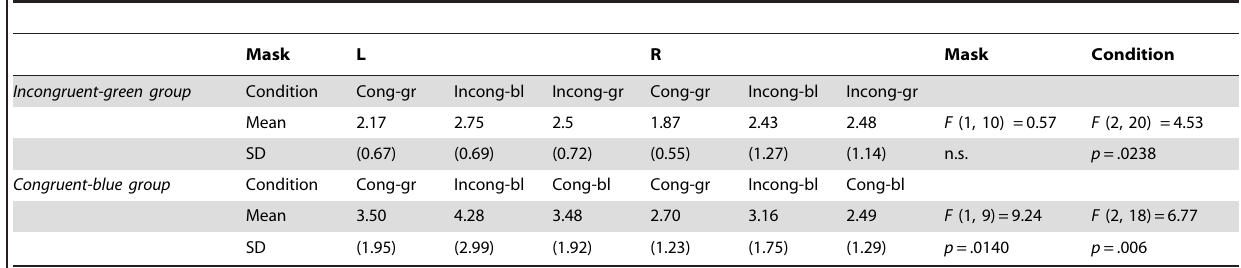
Table 4. Mean endpoint errors in each condition of incongruent-green and congruent-blue groups in the test phase.